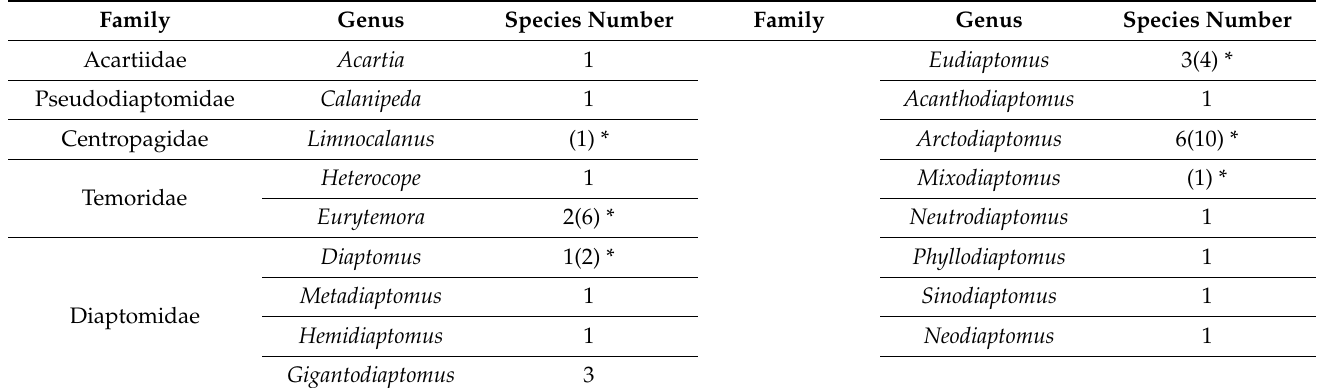
Table 4. Diversity of species of the order Calanoida in water bodies of